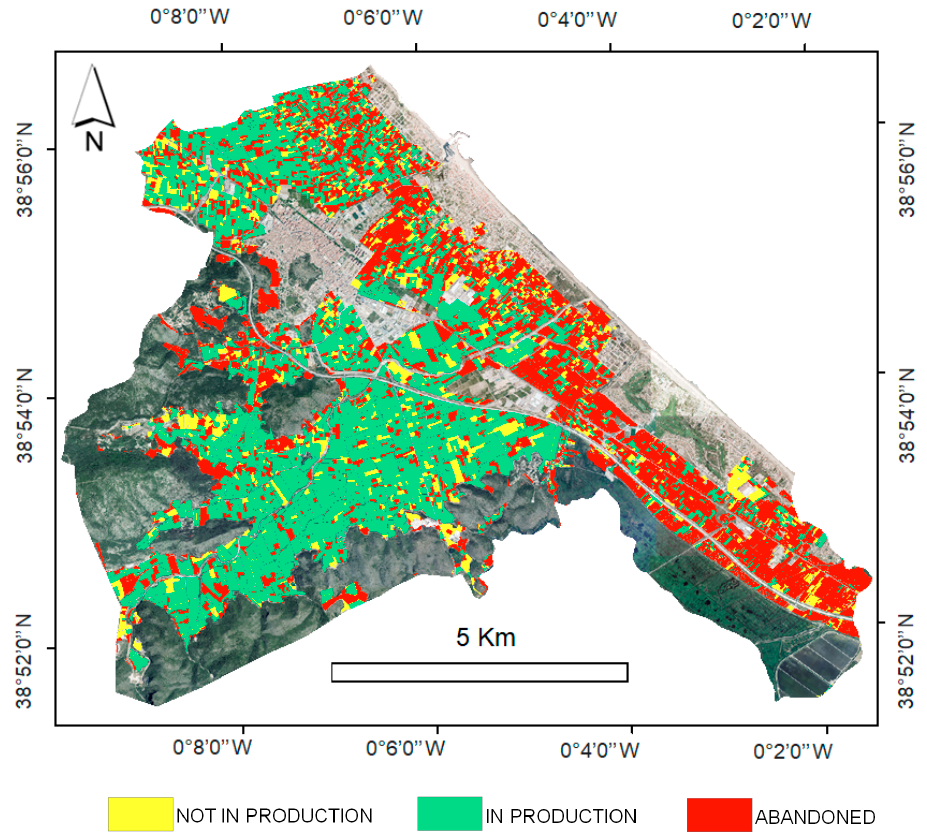
Figure 6. Land abandonment map of the Oliva municipality in 2019. The most accurate model in the main study area was tested in the three complementary areas (Figure 7). According to the photo-interpreted plots, the model has a high overall accuracy (93%) (Table 5). The high accuracy obtained indicates that the model can be applied outside the study area, although the accuracy was lower than in the training area. The most accurate class was not in production, while the most inaccurate class was the abandoned class. This is due to the spectral similarity of the abandoned and in production plots.